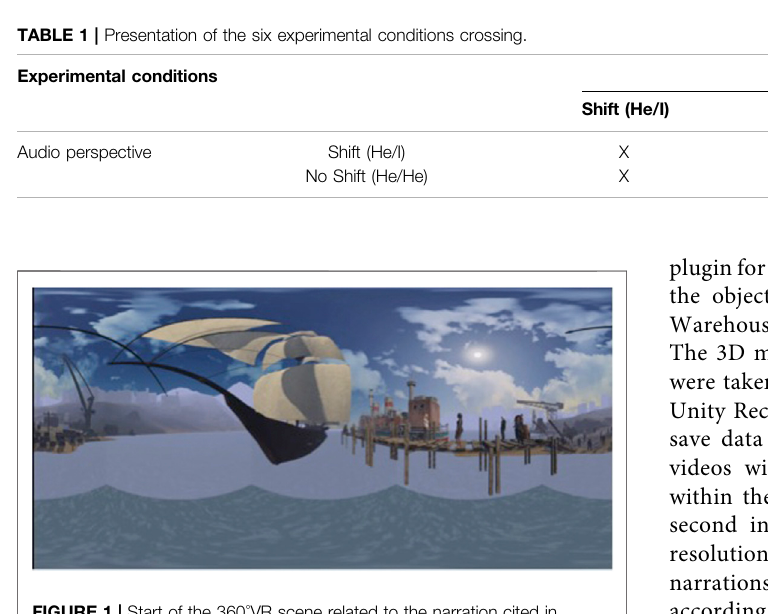
Frontiers in Virtual Reality |